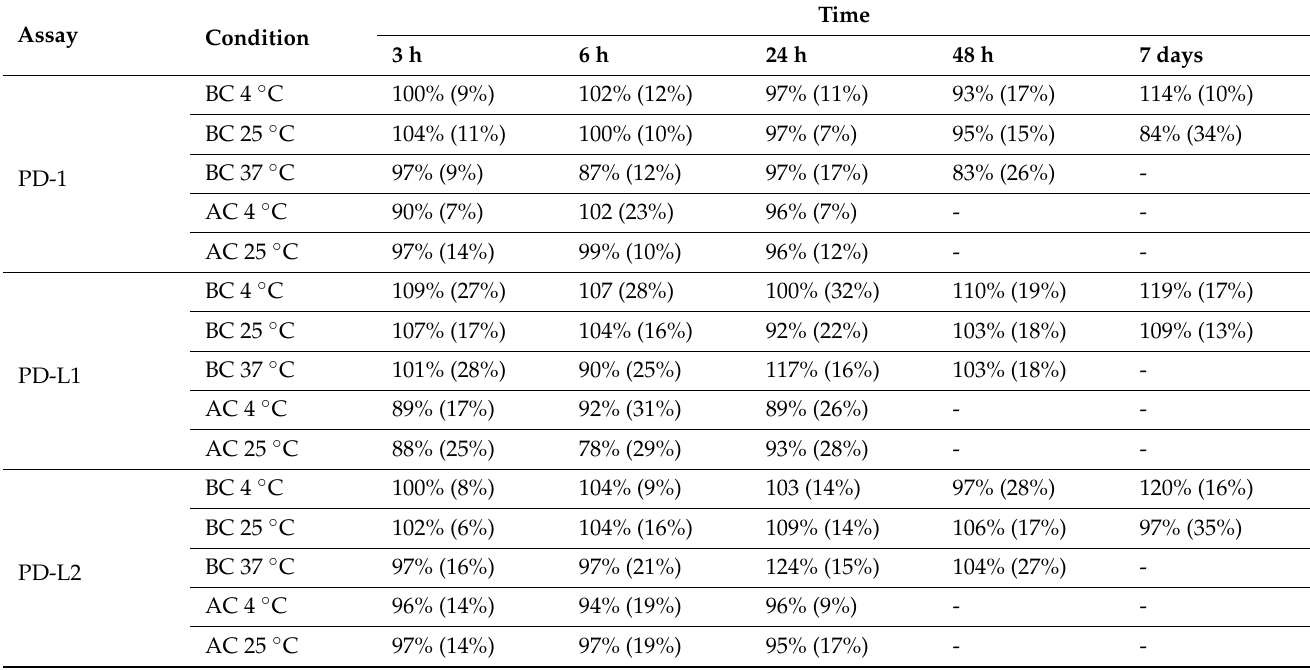
Table 1. Mean recoveries calculated from heparin plasma in course of the short-term stability ex- periment.